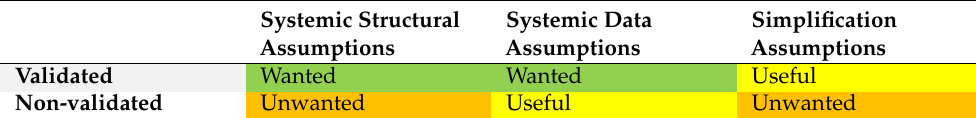
Table 4. Effects of using no validated